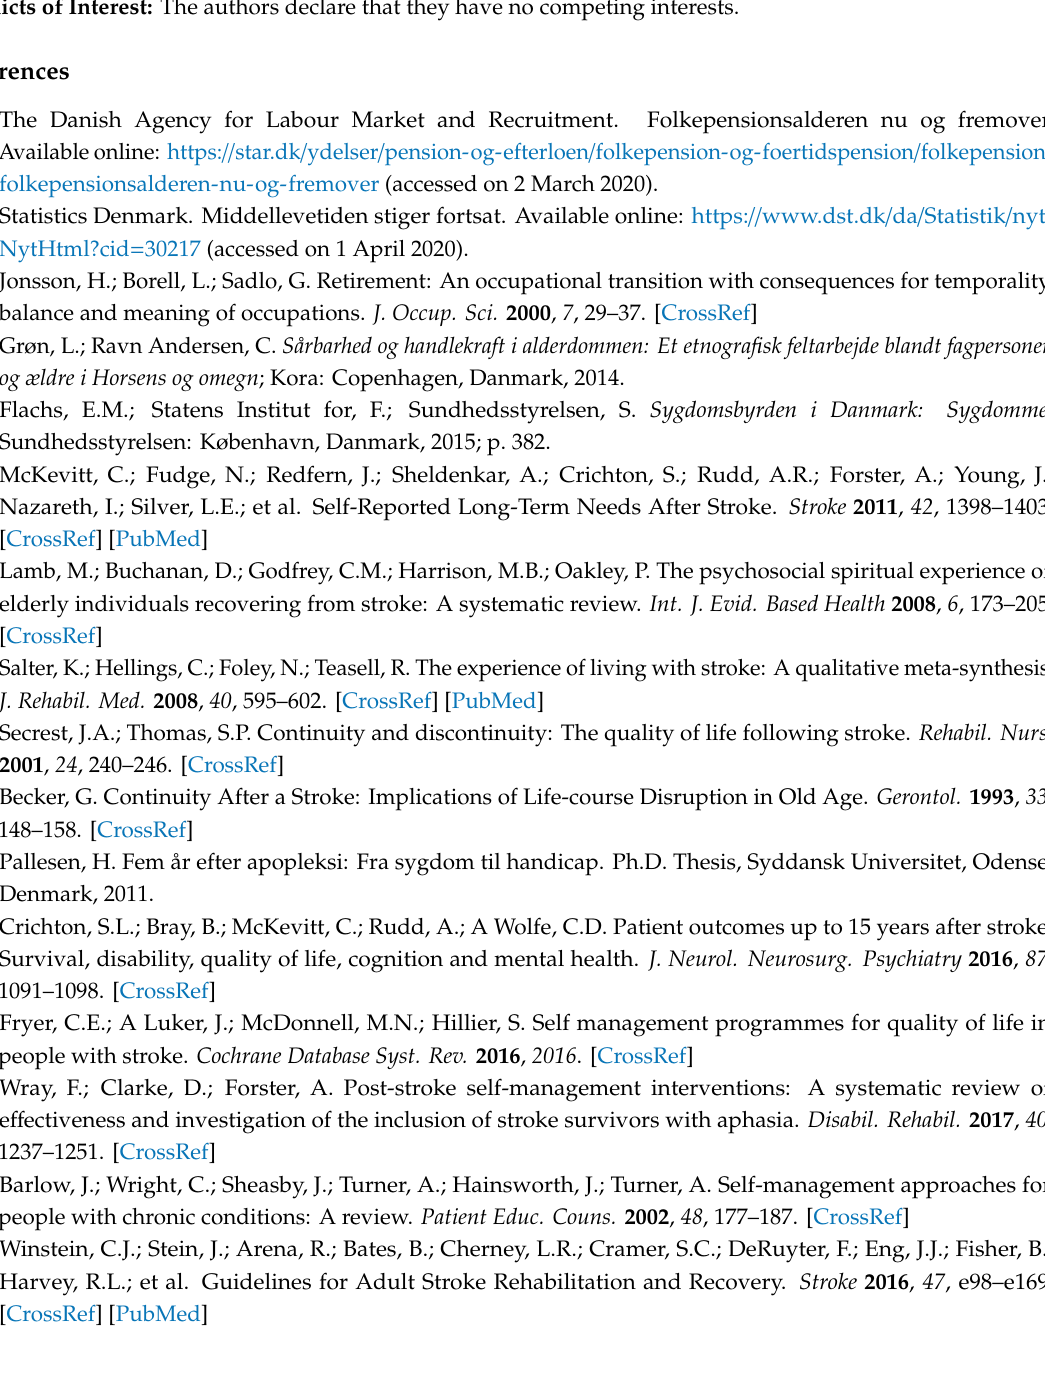
Table S1: PRISMA 2009 checklist; Table S2: electronic search strategies; Table S3: overview of measurements; and Table S4: an overview of the answers to signaling questions, together with free-text justification of the